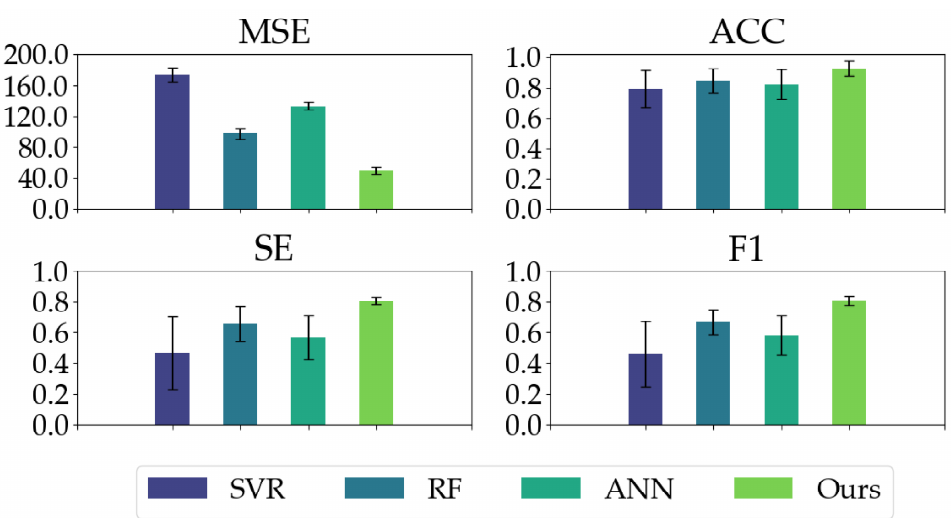
Figure 11. The classification performances (ACC, SE, and F1) of all the models on different anesthetized states (AW, LA, NA, and DA) and the regression performance (MSE) of all the models in cross-subject validation.